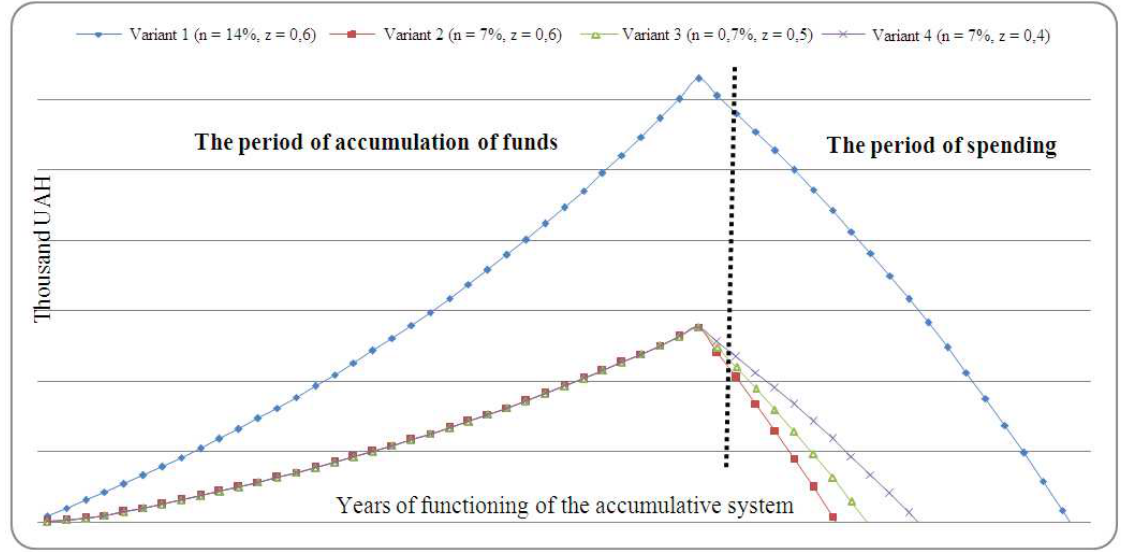
Fig. 3. The dynamics of parameters of the accumulative system according to the variants of accumulation and spending of